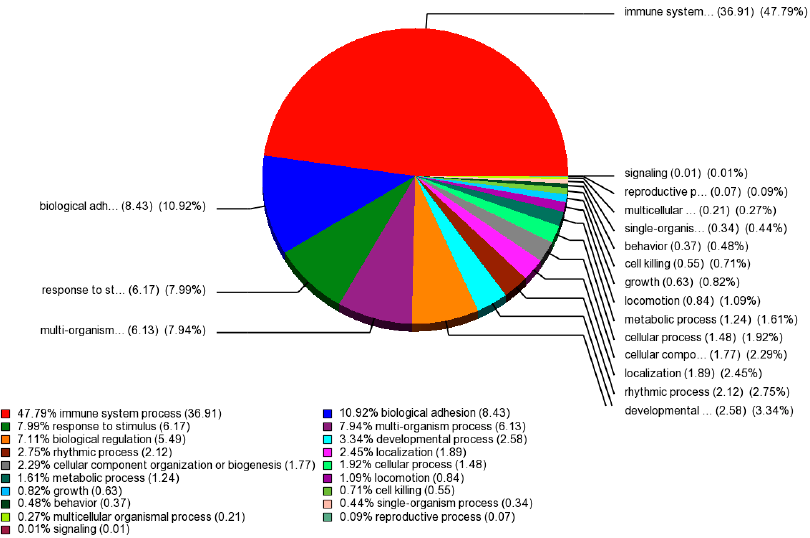
Figure 3. Functional analysis and regulatory effect of differentially expressed genes. Using Ingenuity Pathways Analysis (IPA), Differentially Expressed Genes (DEGs) were overlaid on to the network to find a biological regulatory functional effect based on previously reported interactions in the literature. Function colored with blue denote inhibition and orange denotes activation; development of hematopoietic progenitor cells and development of lymphocytes were inhibited whereas cell death of immune cells as activated function.